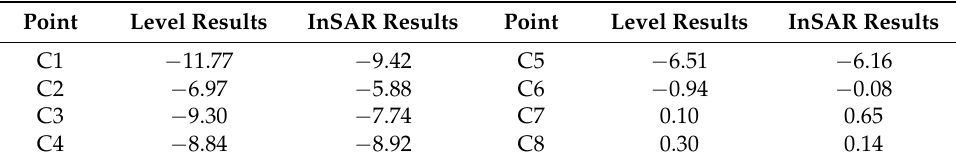
Table 5. The final displacements from leveling and InSAR in China Theater (mm).